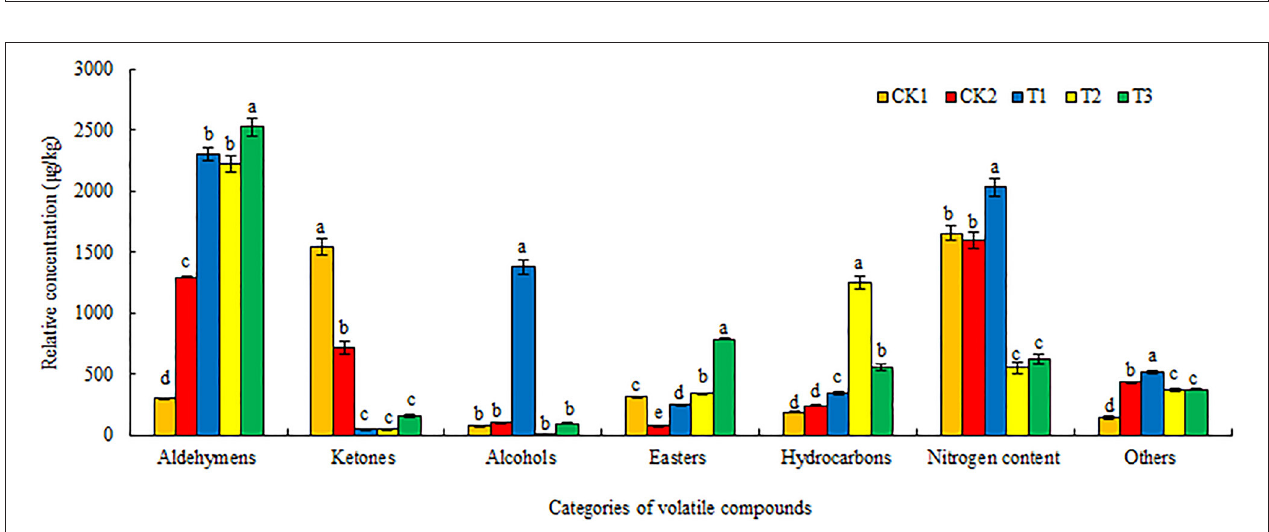
FIGURE 4 | Effects of different ground mulching patterns on the relative concentration of volatile compounds in loose-curd cauliflower heads. Values are expressed as mean ± SE ( n = 3). Different letters denote significant differences ( p < 0.05). CK1, CK2, T1, T2, and T3 are defined in Figure 1